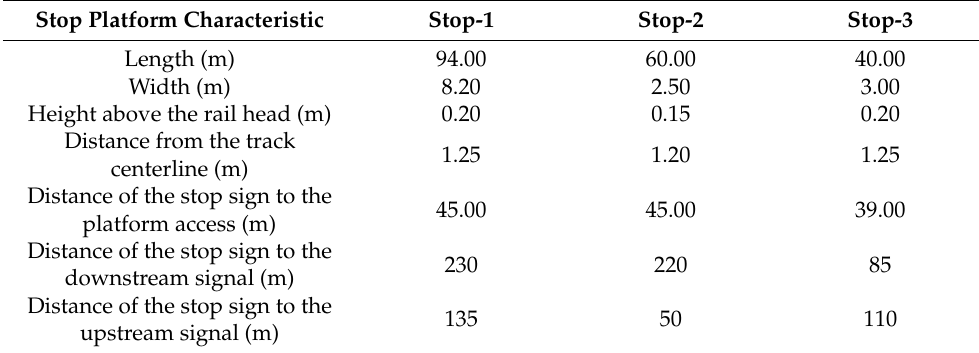
Table 3. Basic stop platform characteristics.